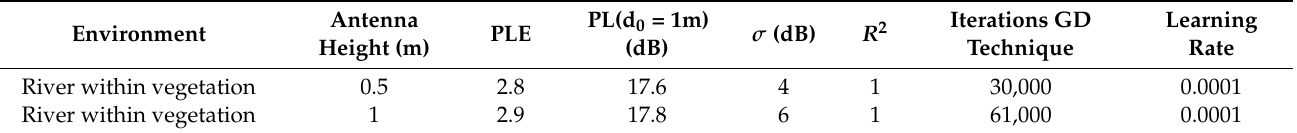
Figure 13. Shadowing between transmitter and receiver in a river within vegetation for both antenna heights of 1 m and 50 cm. Table 7. Parameters of the experimental path loss models.